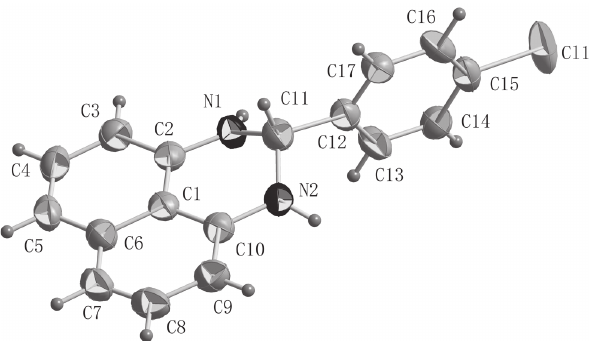
Table 2: Fractional atomic coordinates and isotropic or equivalent isotropic displacement parameters (Å 2